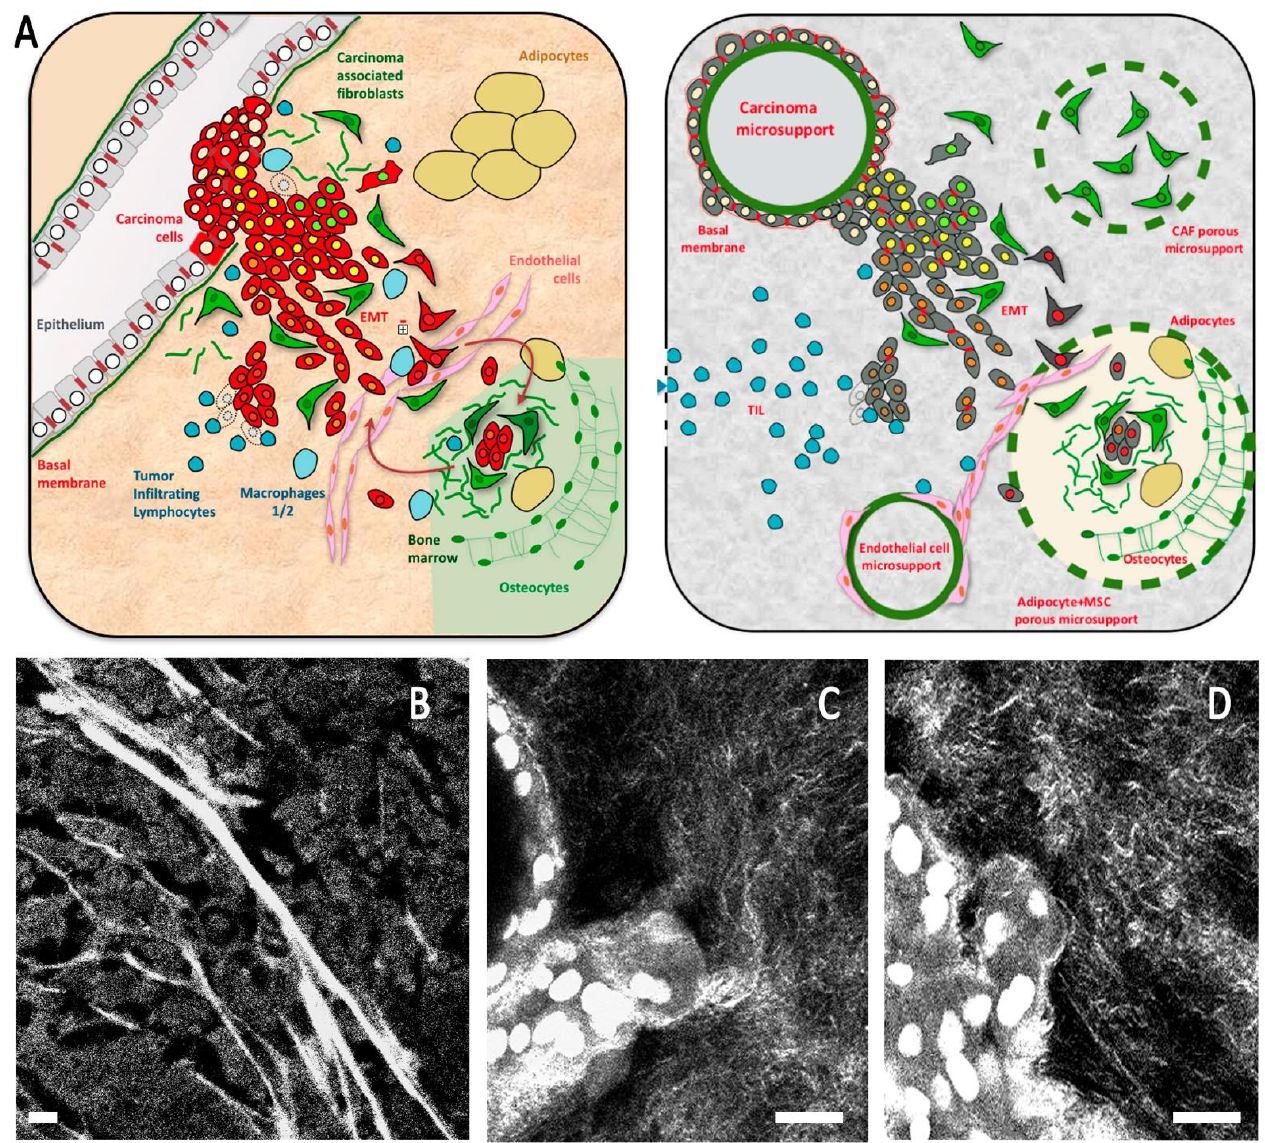
Figure 1. ( A ) Schematic breast cancer microenvironment including the main cell types present in the microenvironment and the composite model design to emulate this organization. ( B – D ) Second harmonic imaging showing organized collagen mesh, including thick fibers in the breast tumor ( B ) and a thinner mesh in composite organoid model including a high proportion of collagen 1 ( C , D ). Scale bar: 20 µm ( B ), 10 µm ( C , D